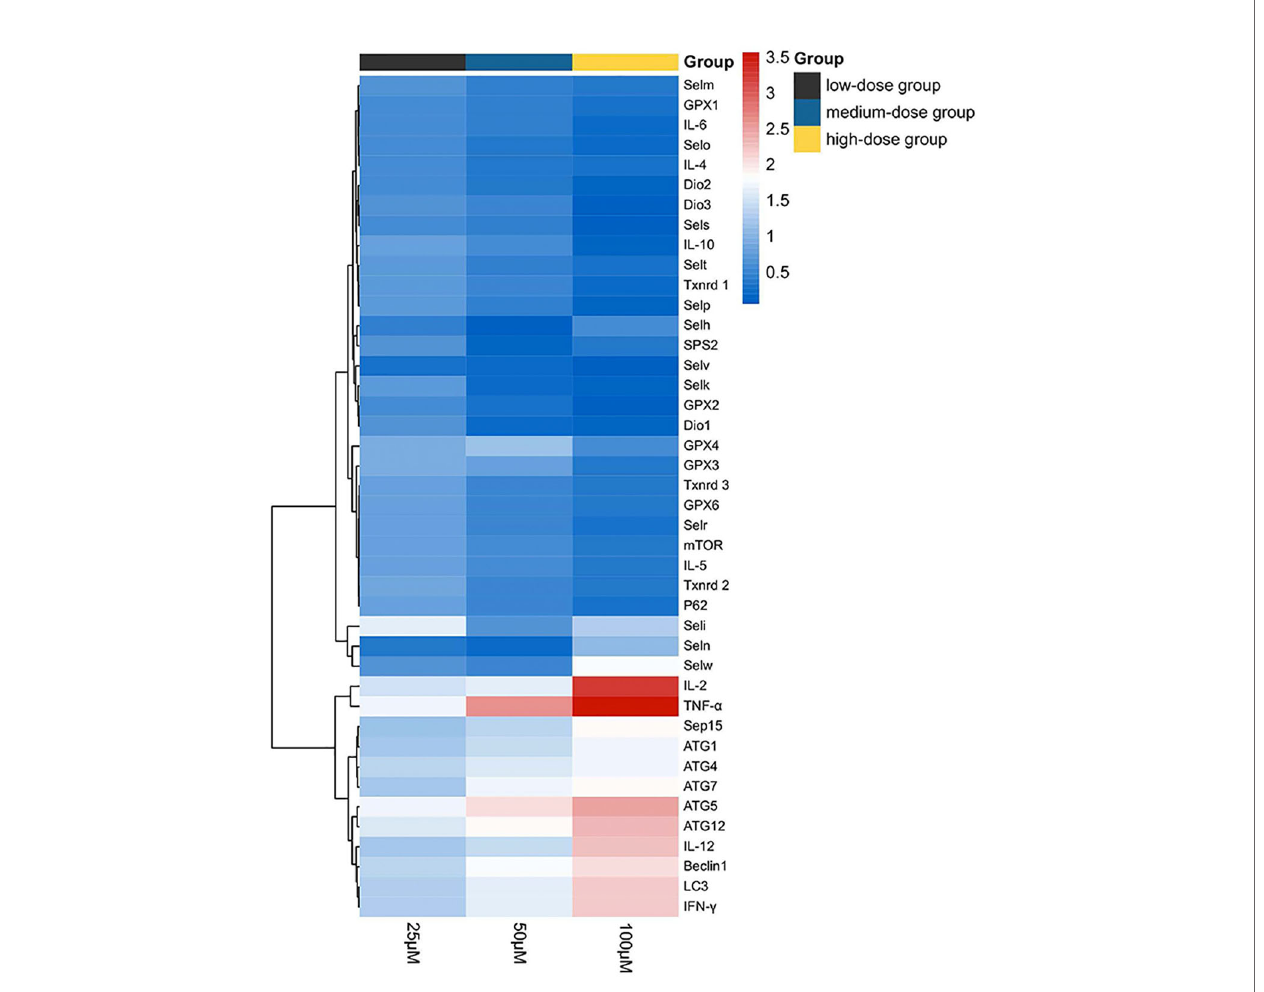
FIGURE 7 | Heat map of autophagy-related genes, related Th1/Th2 cytokines, and selenoprotein mRNA expressions with 25-, 50-, and 100- m M Sch B treatment in Hepa1-6 cells. Rows represent the probe sets. Related genes expressions are shown using the indicated pseudo color scale from blue (0) to red (3.5) relative to values. Red squares represent increased signi fi cantly ( P < 0.05); blue squares represent decreased signi fi cantly ( P < 0.05). Data are presented as mean ±